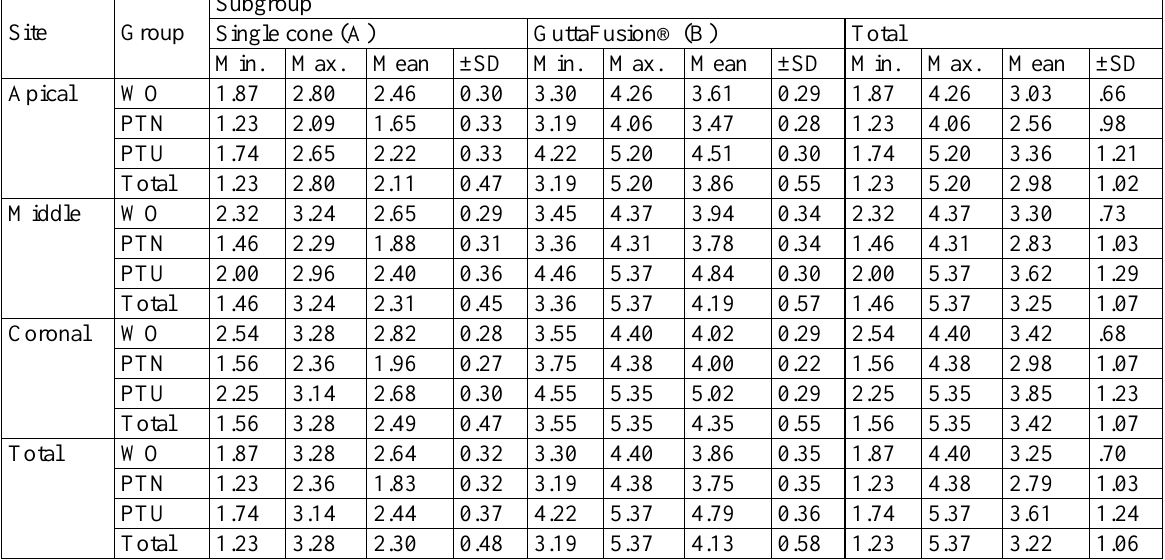
Table 2: Push-out bond strength variability of subgroups in each group by site by using two Site